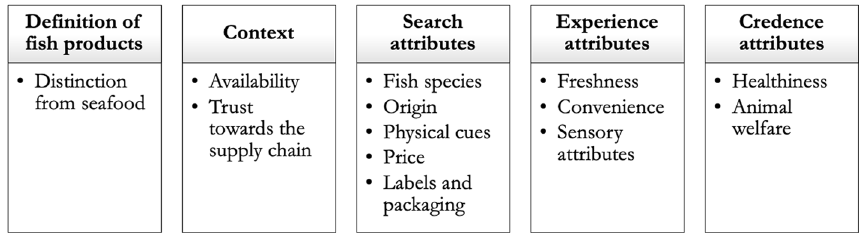
Fig. 2 Factors influencing fish consumption and consumers’